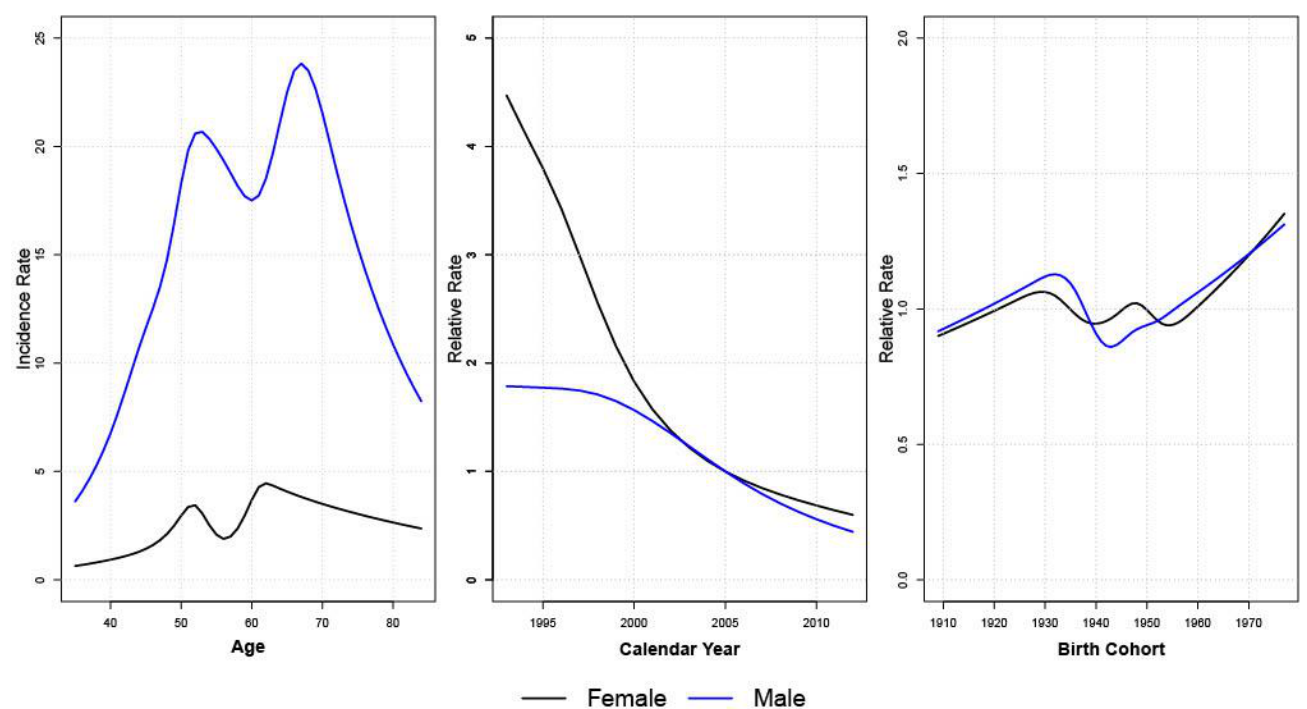
Figure 2. Age, period, and cohort effects of AP-C models for male and female HCC.